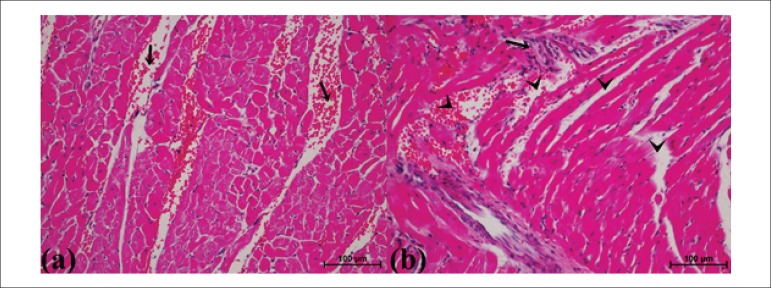
(a) Congestion (arrows) destroyed myofibrils in STZ+ MCAo group.
Cardiac myofibrils are separated from each other along with
congestive area. These areas probably seem to be necrotic areas
accompanied by interstitial edema. (Transverse section, H-E stain,
Magnification: 20X). (b) Mononuclear cell infiltration, congestion
and interstitial edema in necrotic areas (arrows) destroyed cardiac
myofibrils in STZ+ MCAo group (STZ, Streptozotocin-induced diabetic;
IPreC, ischemic preconditioning; MCAo, middle cerebral artery
occlusion, Longitudinal section, H-E stain, Magnification: 20X).